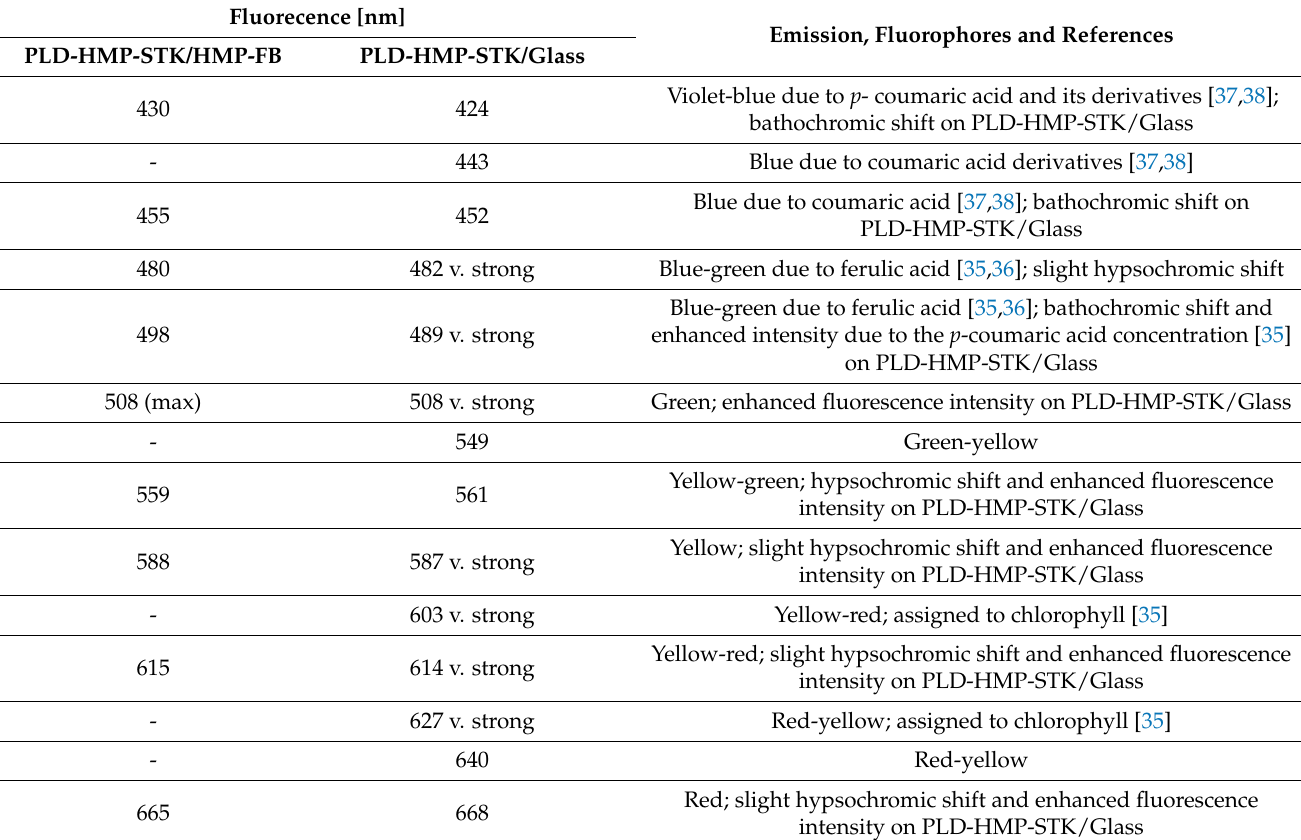
Table 3. The fluorescence peaks of the thin films of PLD-HMP-STK/HMP-FB and PLD-HMP-